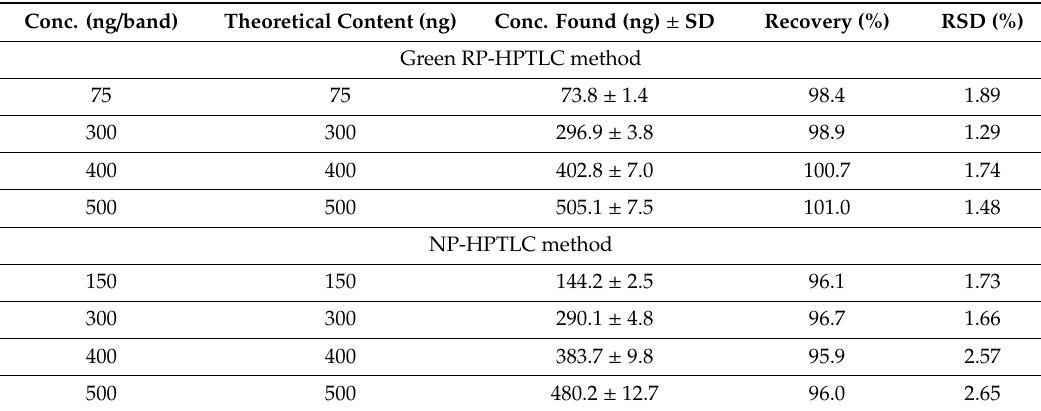
Table 3. Accuracy data for green RP-HPTLC and NP-HPTLC methods ( n = 6). Conc. (ng /